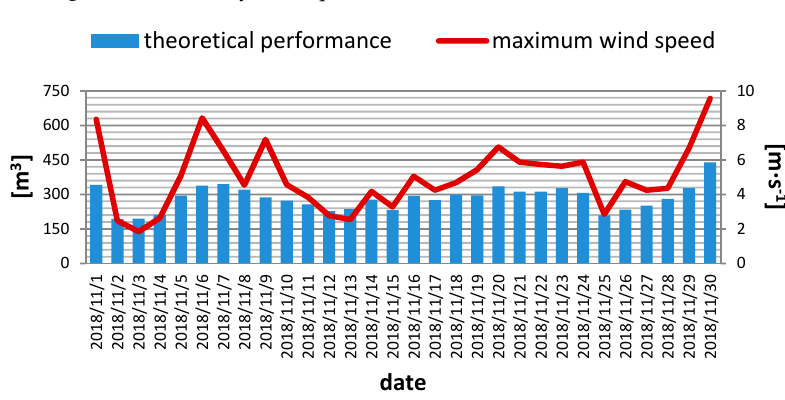
Figure 12. E ffi ciency of the pulverization unit of the aerator in Figure 12. Efficiency of the pulverization unit of the aerator in November.